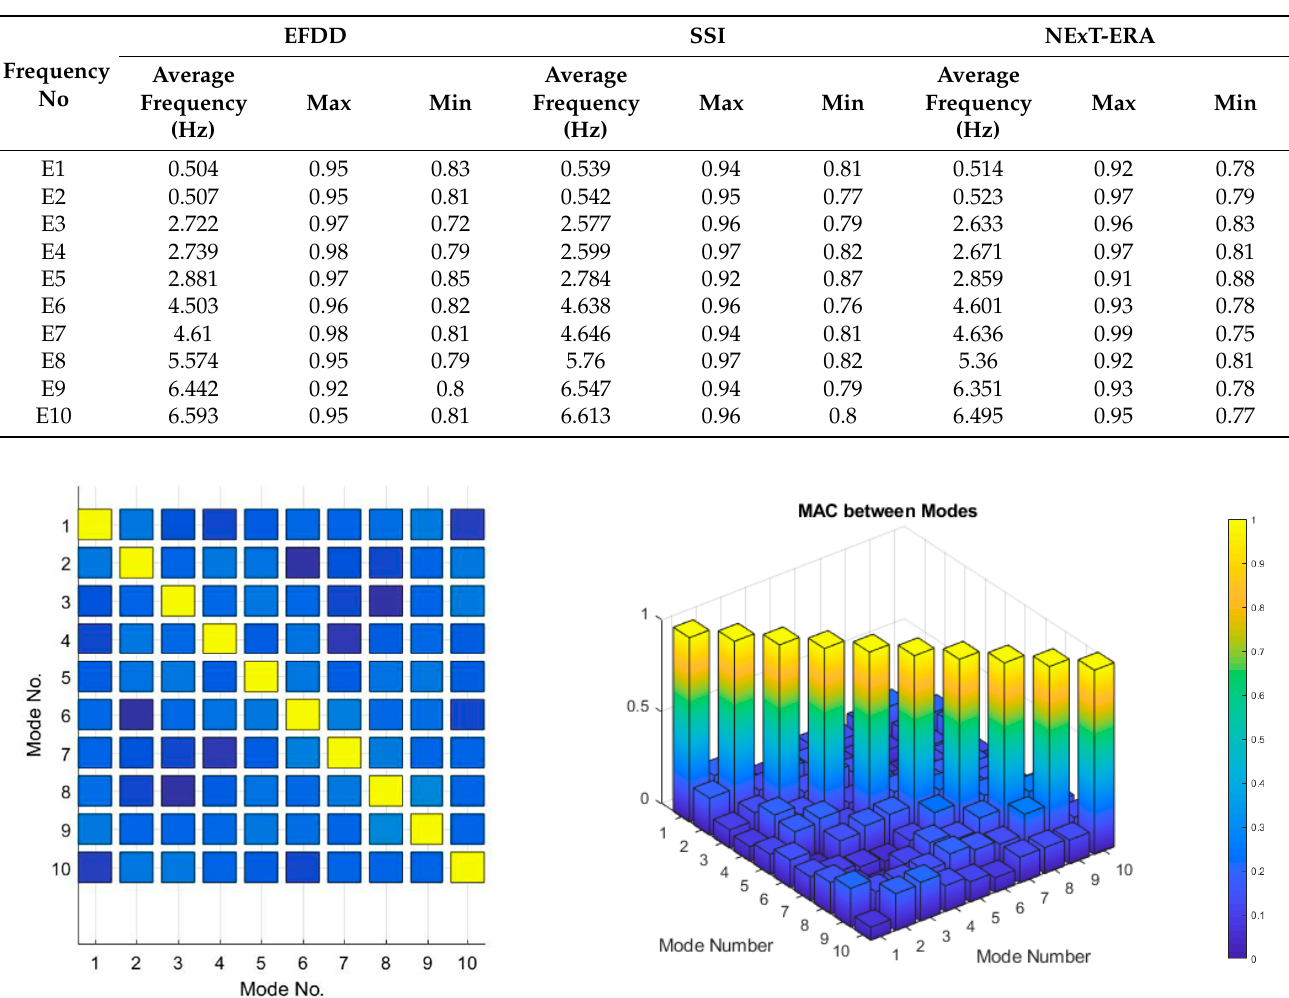
Table 2. The MAC values of the first 10 identified modes from the datasets.